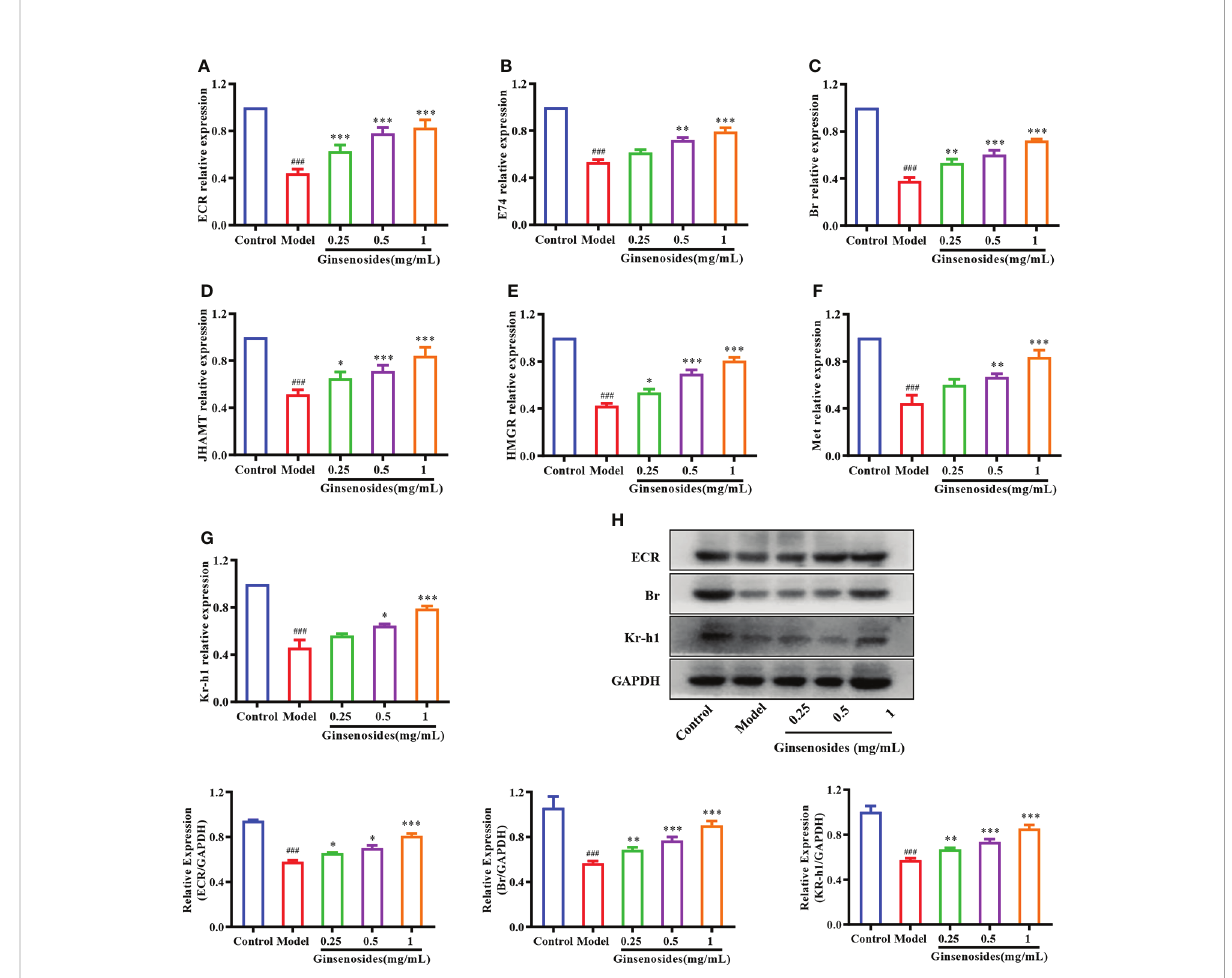
FIGURE 3 Effect of ginsenosides on expression of steroidal signal-related genes in Drosophila . (A) ECR; (B) E74; (C) Br; (D) JHAMT; (E) HMGR; (F) Met; (G) Kr-h1; (H) Relative expression levels of ECR, Br and Kr-h1; GAPDH antibody was used as loading control. ### p <0.001 compared with control (7- day-old female Drosophila ); * p <0.05, ** p <0.01, *** p <0.001 compared with model (35-day-old female Drosophila